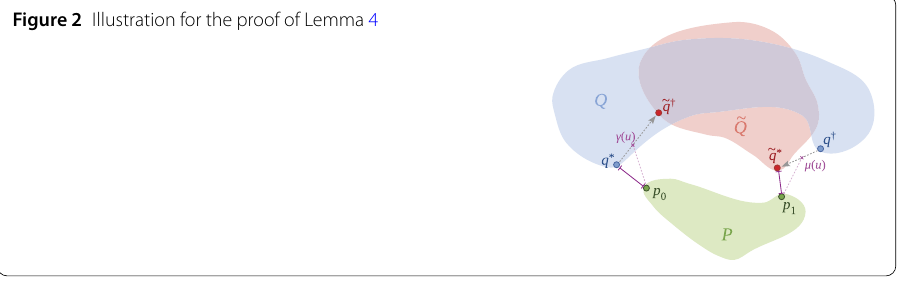
Figure 2 Illustration for the proof of Lemma